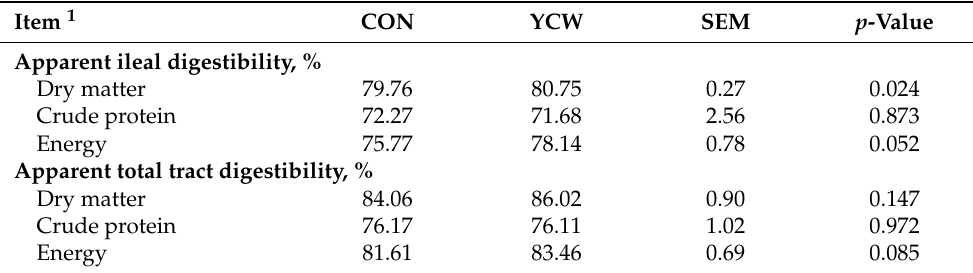
Table 4. Nutrient digestibility and intestinal morphology of weaned pigs fed diets with or without dietary yeast cell